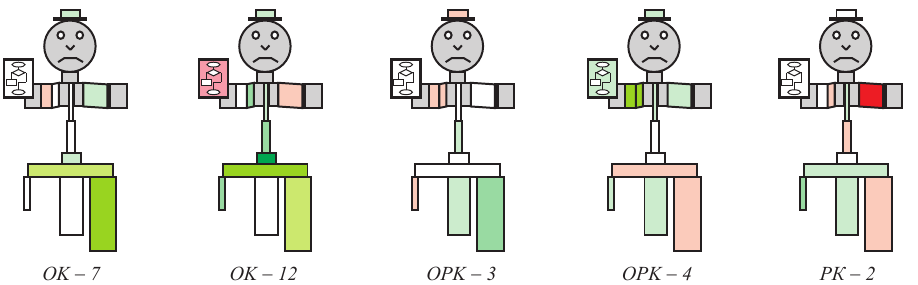
Figure 11. Development levels of five competences for the same student visualized using the UGVA notation.